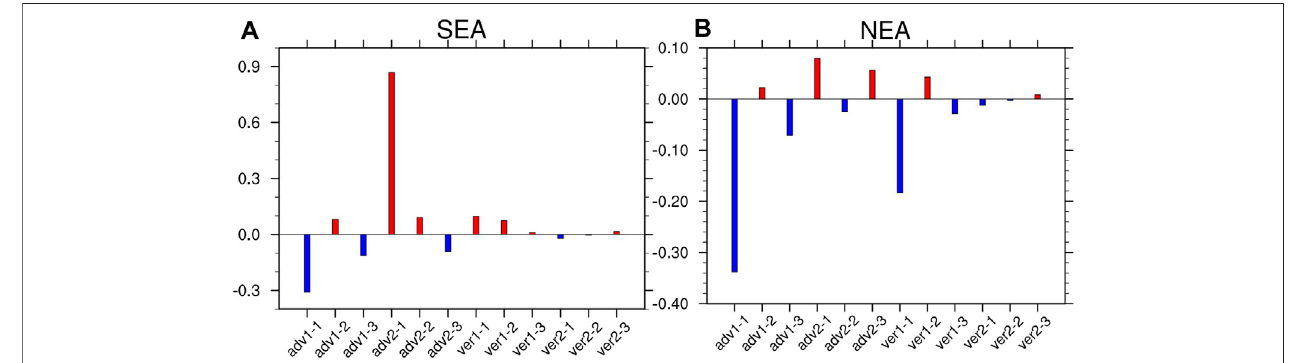
FIGURE 12 | The regional averaged moisture budget for each term (adv1-1, − Δ V E · ∇ q p , adv1-2, − V Ep · ∇ ( Δ q ) , adv1-3, − Δ V E · ∇ ( Δ q ) , adv2-1- − V p · ∇ ( Δ q E ) , adv2- 2, − V · ∇ ( q Ep ) , adv2-3, − Δ V · ∇ ( Δ q E ) , ver1-1, − Δ ω E · z q p z NEA (B) in CMIP5 for the following